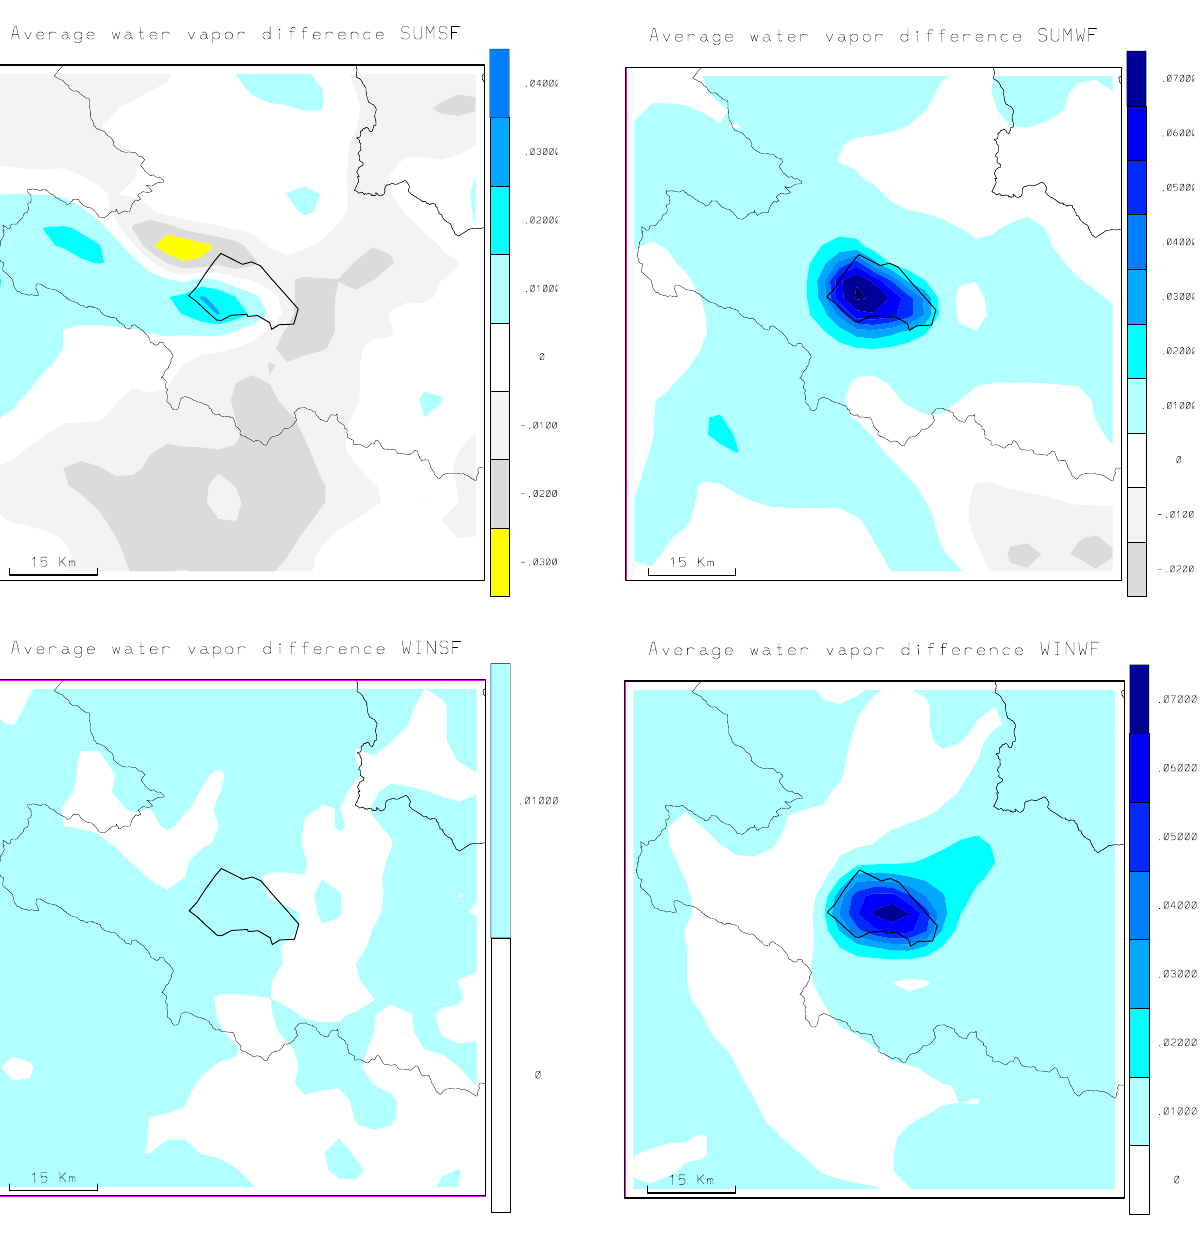
Fig. 10. Average water vapor difference between cases with the lake and without the lake. (a) SUMSF; (b) SUMWF; (c) WINSF; (d) WINWF. Units are